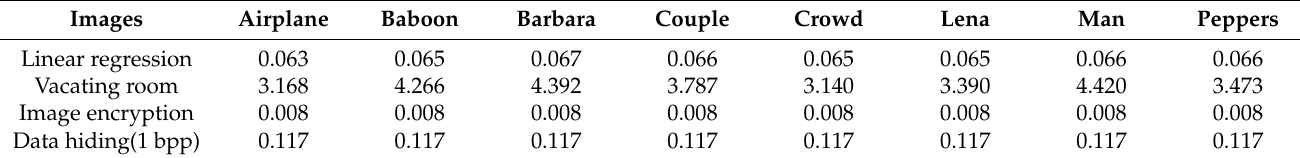
Table 2. Comparison of embedding rates for the eight test images